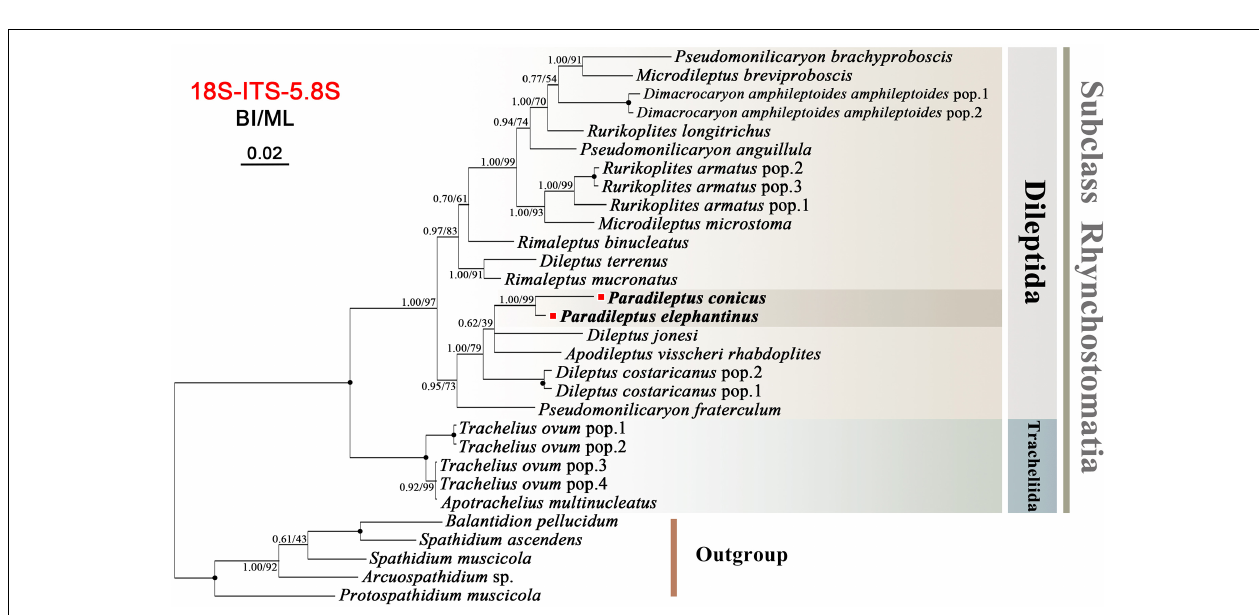
FIGURE 7 | Bayesian inference (BI) tree inferred from ITS-5.8S rDNA sequences focusing on the subclass Rhynchostomatia (26 rhynchostomatian and five spathiid taxa). Numbers near branches show the posterior probabilities from BI and bootstrap values from maximum likelihood (ML) analyses. Asterisks indicate a mismatch in branching pattern between the BI and ML trees. Fully supported (1.00/100) branches are marked with solid circles. The newly sequenced species in this study are shown in bold. The scale bar corresponds to 5 substitutions per 100 nucleotide positions.